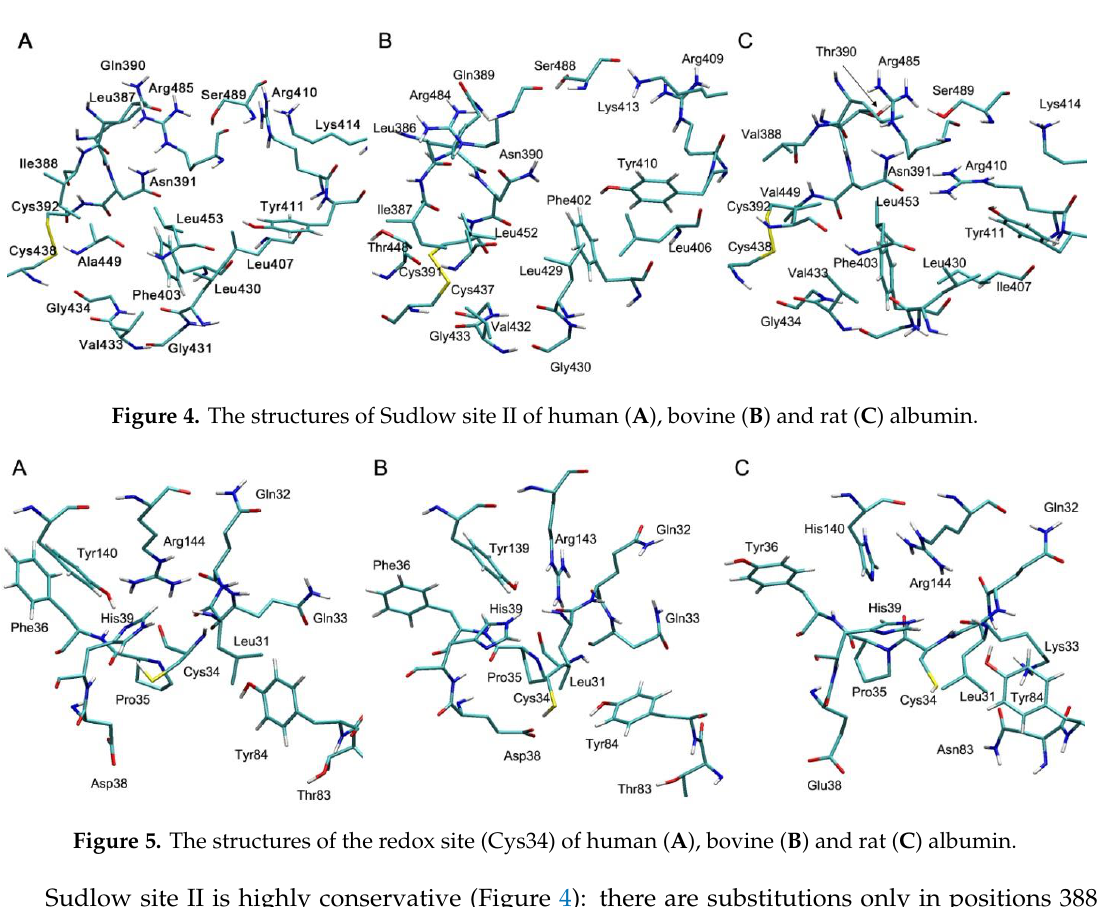
Figure 5. The structures of the redox site (Cys34) of human ( A ), bovine ( B ) and rat ( C )